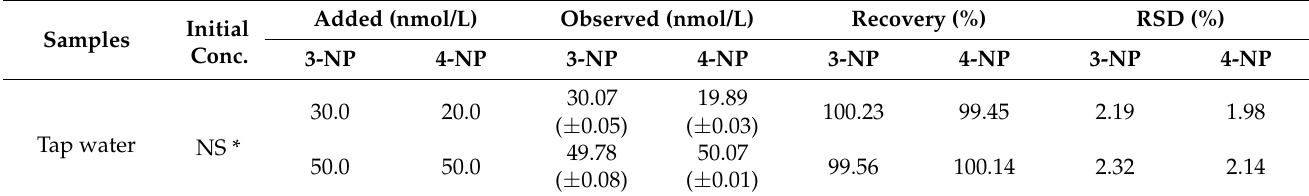
Table 2. Estimation of 3-NP and 4-NP in different environmental water